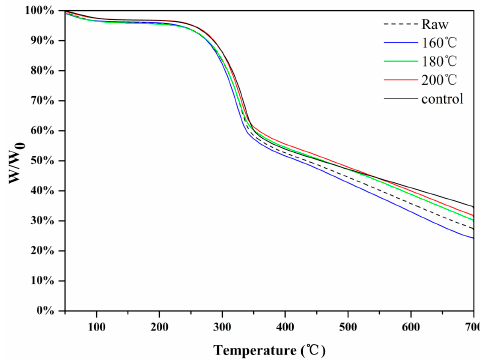
Figure 3. Pyrolysis curves of wheat straw and fiberboards produced at different temperatures.